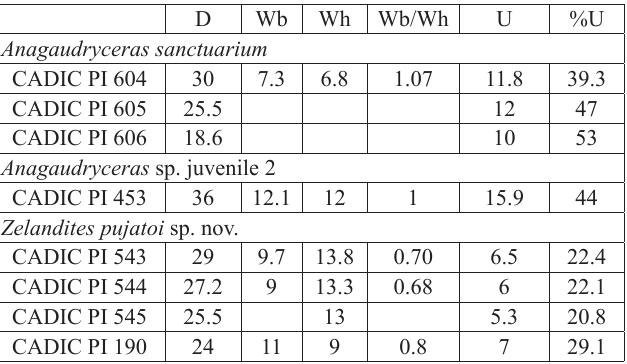
Table 6. Dimensions (in mm) of Anagaudryceras sanctuarium Raffi and Olivero sp. nov., Anagaudryceras sp. juvenile 2, and Zelandites pujatoi sp. nov. Abbreviations: D, diameter; U, umbilical diameter; %U, umbilical dia meter as % of D; Wb, whorl breadth at a given D; Wh, whorl height at a given